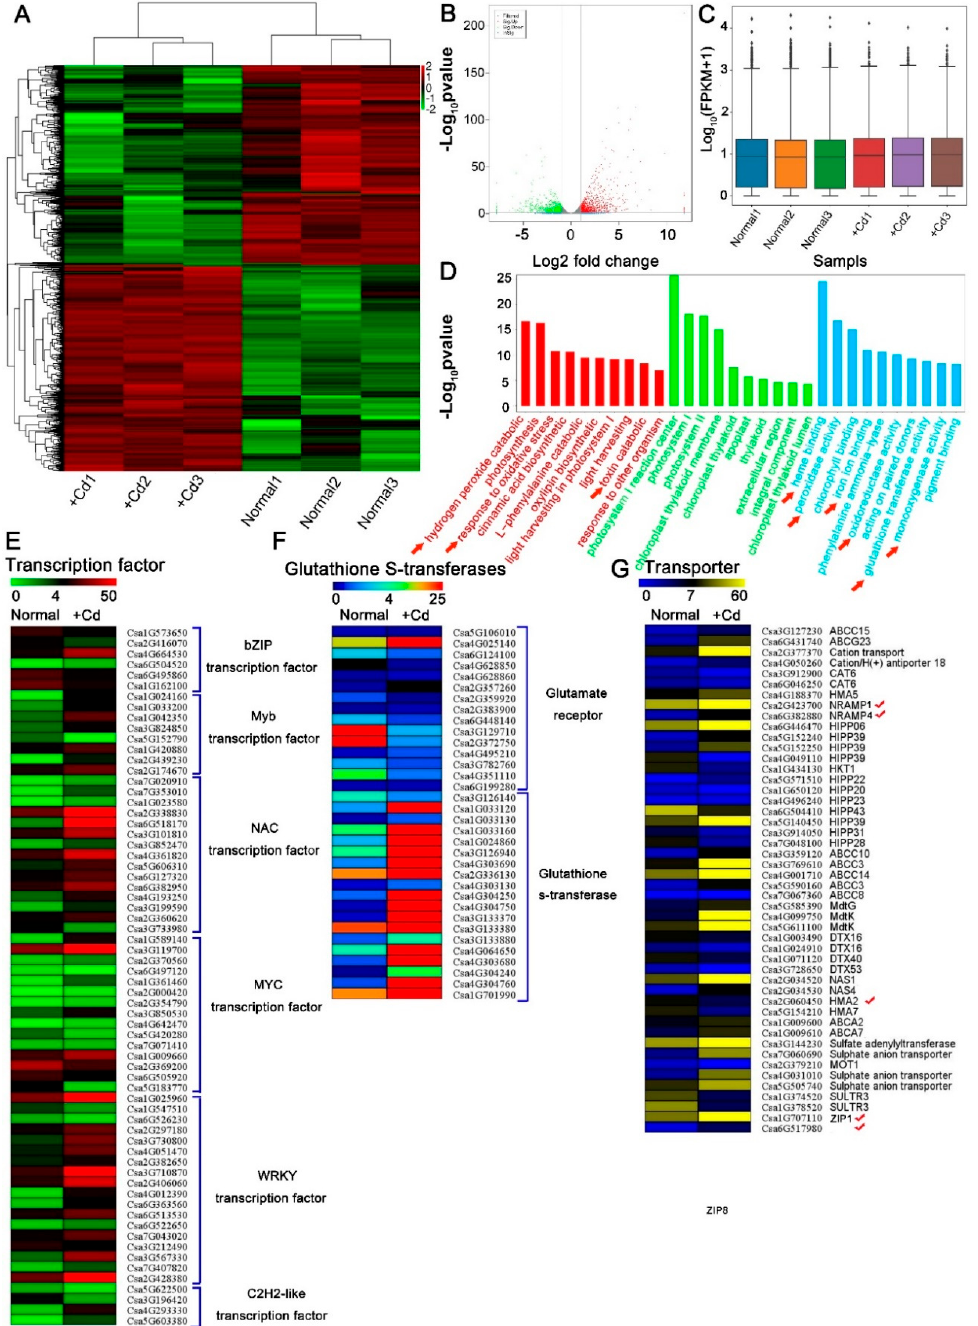
Figure 2. Analysis of Cd-exposed cucumber transcriptome. ( A ) Heatmap representation of a one-dimensional hierarchical clustering of differential gene expression as determined by mRNA-seq for Cd-exposed cucumber relative to normal plant (Cd-free). ( B ) Differential transcript abundance of Cd-free and Cd-treated seedlings. The x -axis represents the log2 fold change under the mean normalized expression of all transcripts ( y -axis). Green (downregulation) and red (upregulation) dots indicate differential genes ( p < 0.01). ( C ) Box–whisker plot FPKM (fragments per kilobase of exon per million fragments mapped) of six samples (Normal1, Normal2, Normal3, +Cd1, +Cd2 and +Cd3). ( D ) GO enrichment analysis of Cd-exposed and normal cucumber transcripts in seedlings. ( E – G ) Hierarchical clustering of differentially expressed mRNAs that were significantly different in transcript abundance between Cd-free and Cd-exposed cucumbers. Heat map represented the gene expression level of Cd-respond mRNAs ( p < 0.05). √ mean candidate cadmium transporter. Ten-day-old cucumber seedlings were exposed to 0 (Normal) or 50 µ M Cd (+Cd) for 4d, and the whole plant was selected for RNA extraction. Significance of differences between the treatments was statistically evaluated ( p <